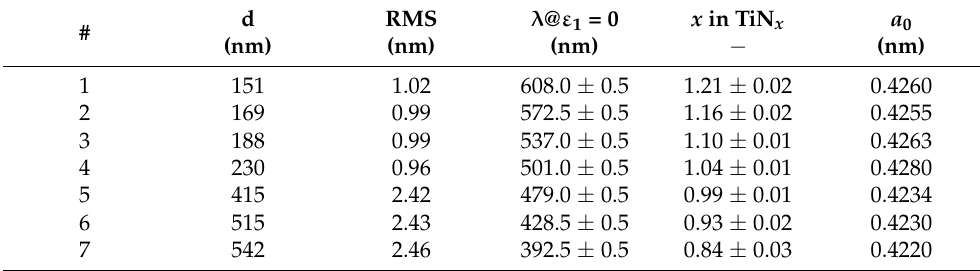
Table 1. Measured values of selected parameters that characterize deposited thin